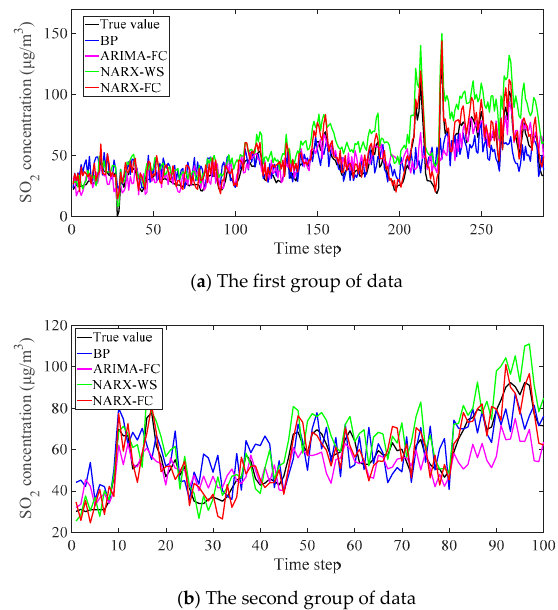
Figure 7. Prediction results of SO 2 concentration.